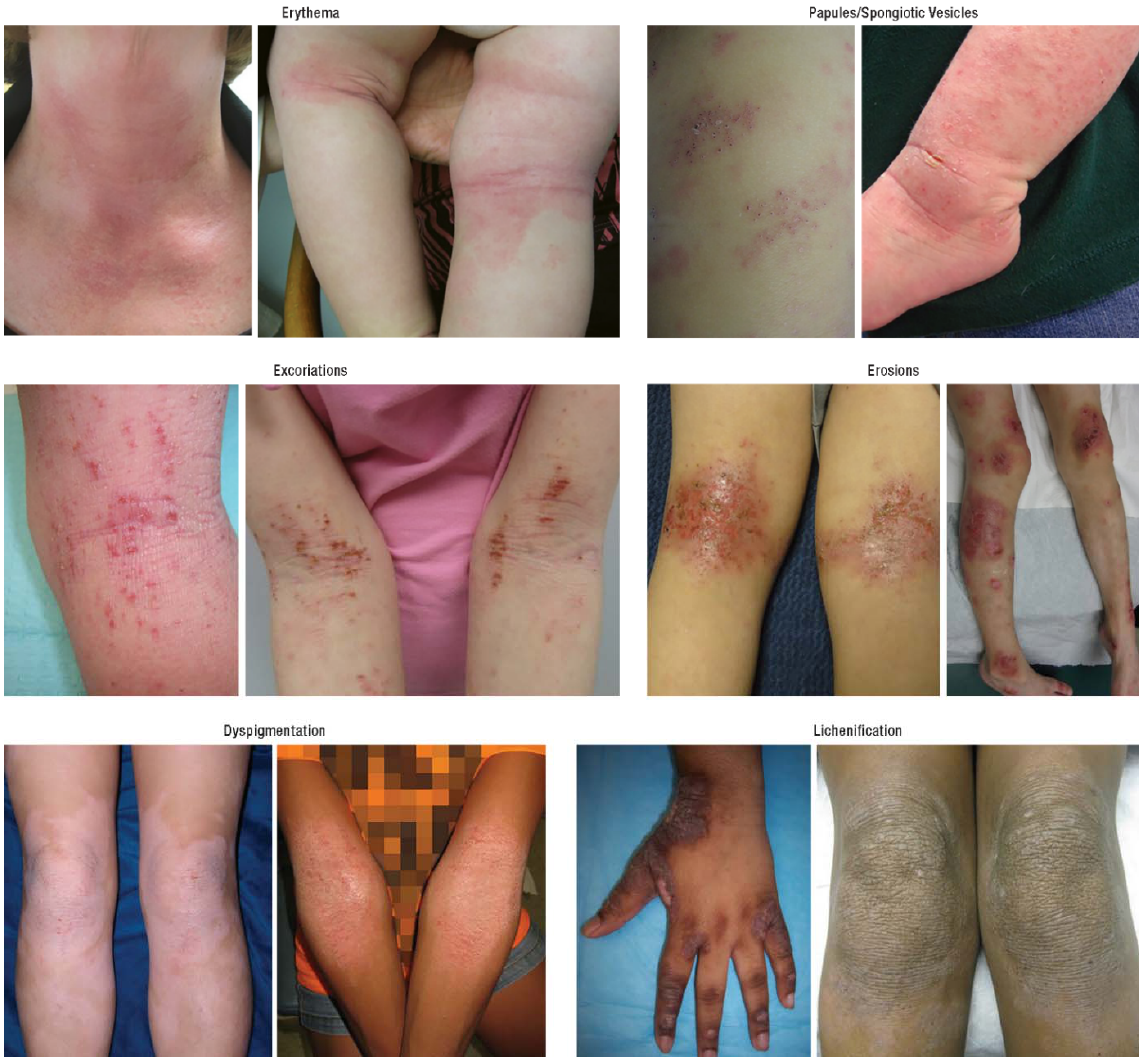
Figure 1. Atopic dermatitis: clinical